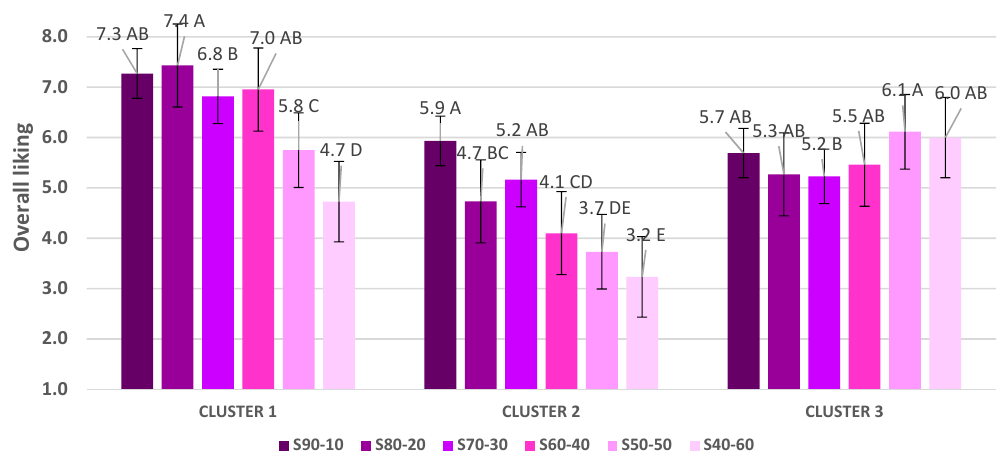
Figure 3. Mean Overall liking by Cluster 1 ( n = 44), Cluster 2 ( n = 30), and Cluster 3 ( n = 26) for each sample (S90-10, S80-20, S70-30, S60-40, S50-50 and S40-60 correspond to each sample of PJ and GT concentrations respectively). Samples with different letters were significantly different ( p < 0.05)